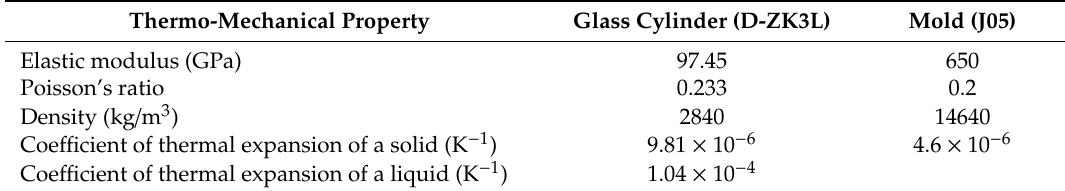
Table 5. Thermodynamic characteristics of glass and mold.